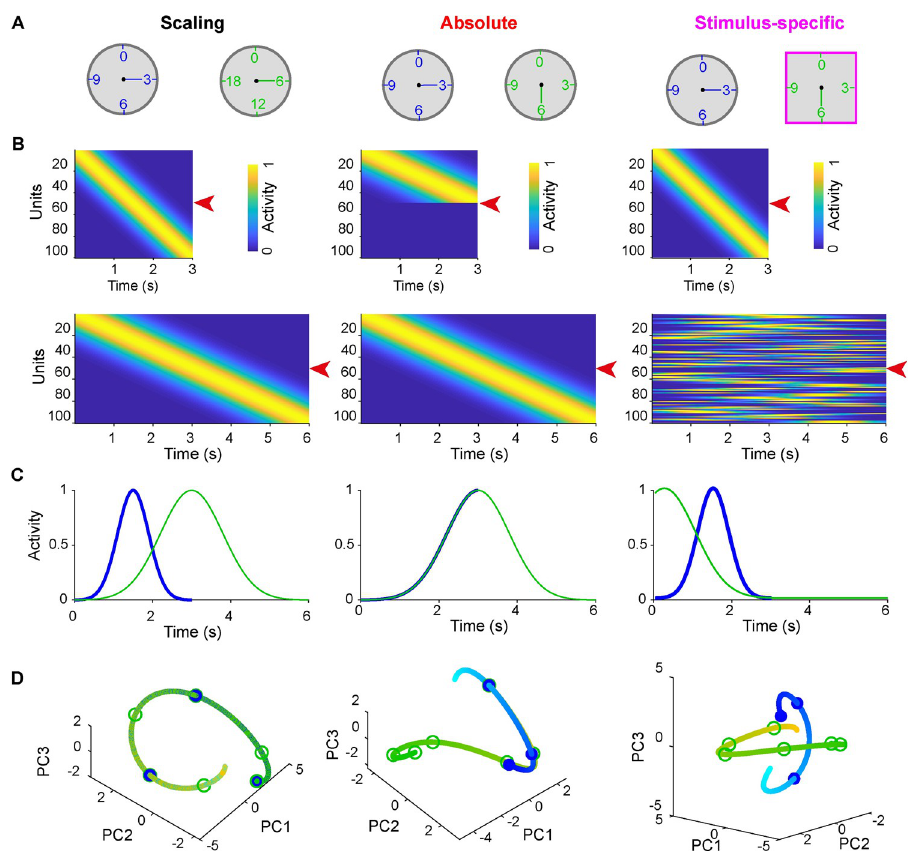
Fig 3. Three strategies for the encoding of two intervals by the same group of neurons. ( A ) Schematic of three potential strategies for timing two intervals: scaling, absolute, and stimulus-specific from left to right. ( B ) Prototypical dynamics for each of the encoding schemes for a population of units during production of the short (top) and long (bottom) intervals. ( C ) Activity traces of the units denoted by the red arrows in ( B ) for short (blue) and long (green) intervals. ( D ) Trajectories of three PCA components for short (cyan-blue) and long (yellow-green) interval for the corresponding population dynamics. The gradient colors (from the light to the dark) denote the flow of time. Circles denote the time points of the 1st, 2nd, 3rd, 4th, 5th, and 6th